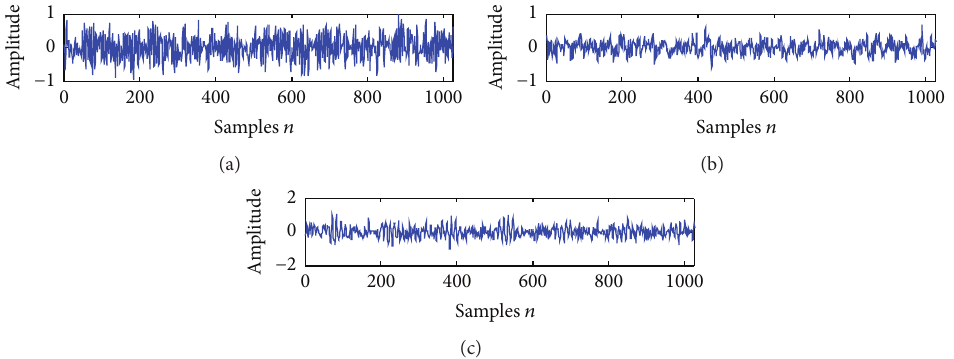
Figure 3: Gearbox vibration signals under various operating